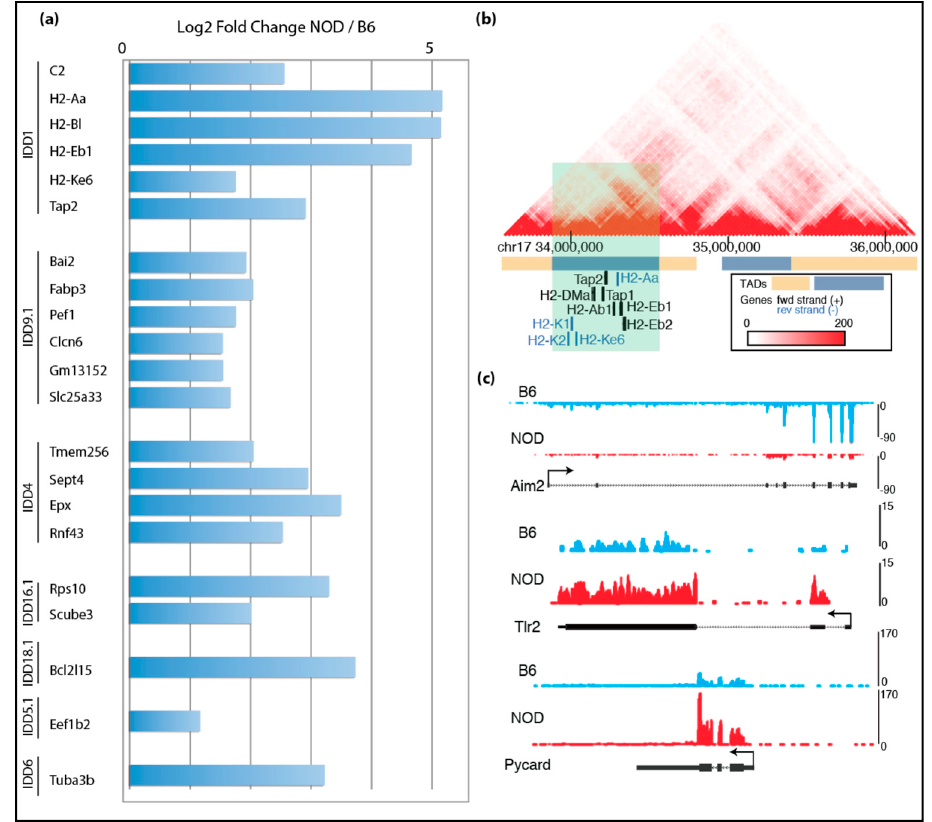
Figure 2. Transcriptomic comparison of NOD and B6 ES cells: ( a ) mRNA-Seq data show up-regulated genes found in Idd regions of NOD ES cells compared to B6 ES cells; ( b ) genes that are up-regulated in NOD Idd1 region belong to the same topological associating domain (TAD); ( c ) UCSC genome browser tracks show that Aim2 is up-regulated in B6 ES cells, while Tlr2 and Pycard are up-regulated in NOD ES cells.